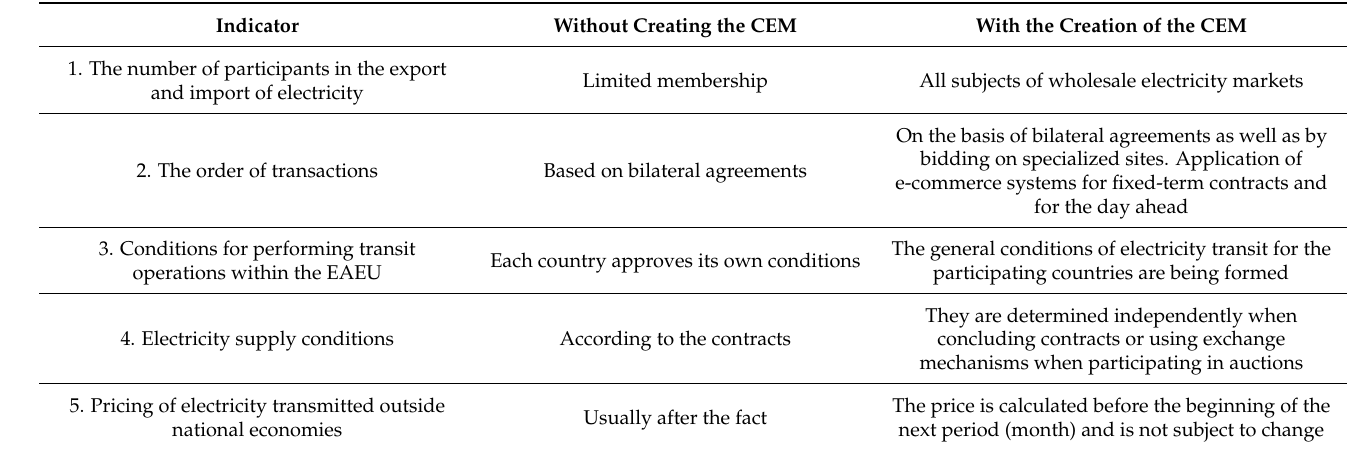
Table 10. Changes in the terms of electricity trade after the formation of the